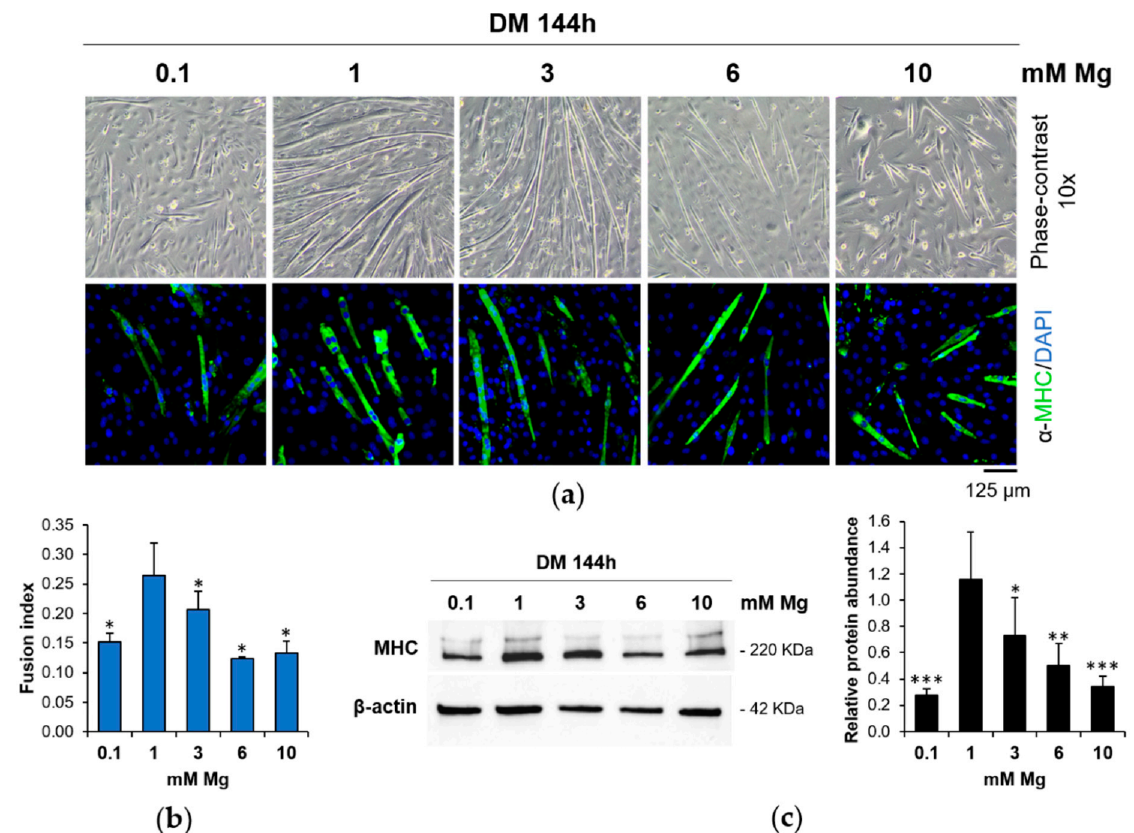
Figure 1. Low and high Mg concentrations inhibit myogenesis. C2C12 cells were cultured in differentiation medium (DM) for 144 h in the presence of different extracellular concentrations of Mg. ( a ) Pictures were taken with optical microscope (10 × magnification, upper panels). After immunofluorescence with antibodies against Myosin Heavy Chain (MHC; green fluorescence), images were acquired using a fluorescence microscope (10 × magnification, lower panels). The nuclei were stained with 4 (cid:48) ,6-diamidino-2-phenylindole (DAPI). ( b ) Fusion index was calculated as the ratio of the number of nuclei within myotubes (>2 nuclei) to the total number of nuclei in the field and quantified based on ( a ). ( c ) MHC levels were analyzed by Western blot. β -actin was used as control of loading. A representative blot (left) and densitometry performed on three independent experiments and obtained by ImageLab (right) are shown. * Indicates significance with respect to 1 mM Mg (* p ≤ 0.05; ** p ≤ 0.01; *** p ≤